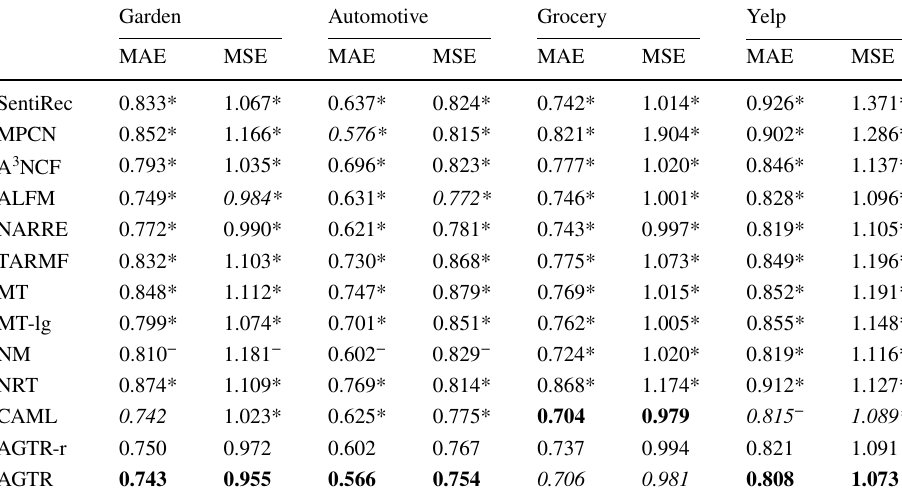
Table 3 Rating prediction performance in terms of MAE and